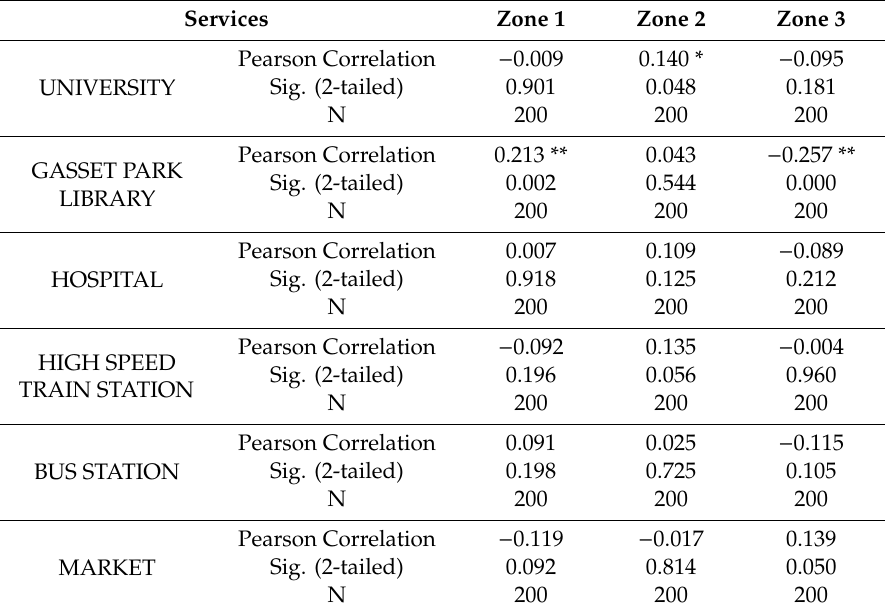
Table 5. Results of answers related to city